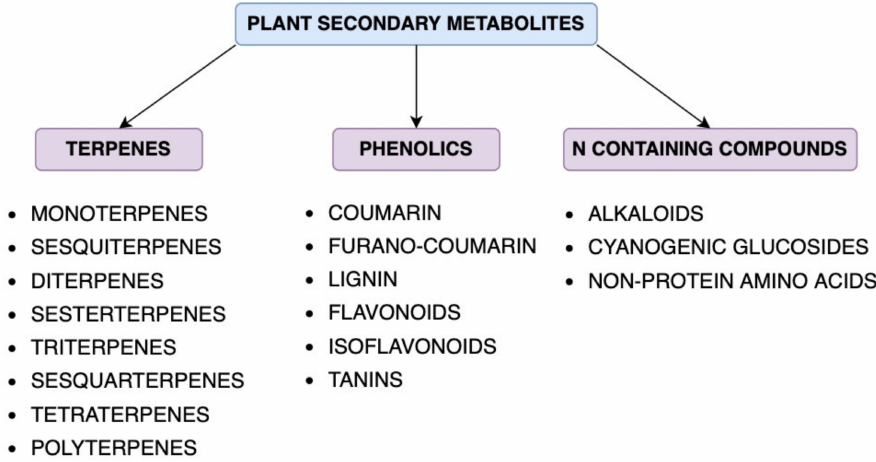
Figure 2. The three major types of secondary metabolites